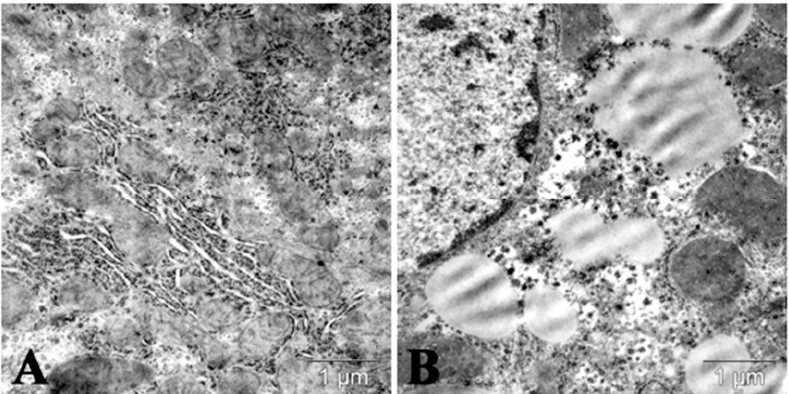
Figure 1. The serum lipid profile of untreated CBA mice and CBA mice with acute lipemia induced by different doses of poloxamer 407, mmol/L (mean ±SD). * p < 0.01 vs. control; ** p < 0.001 vs. control.